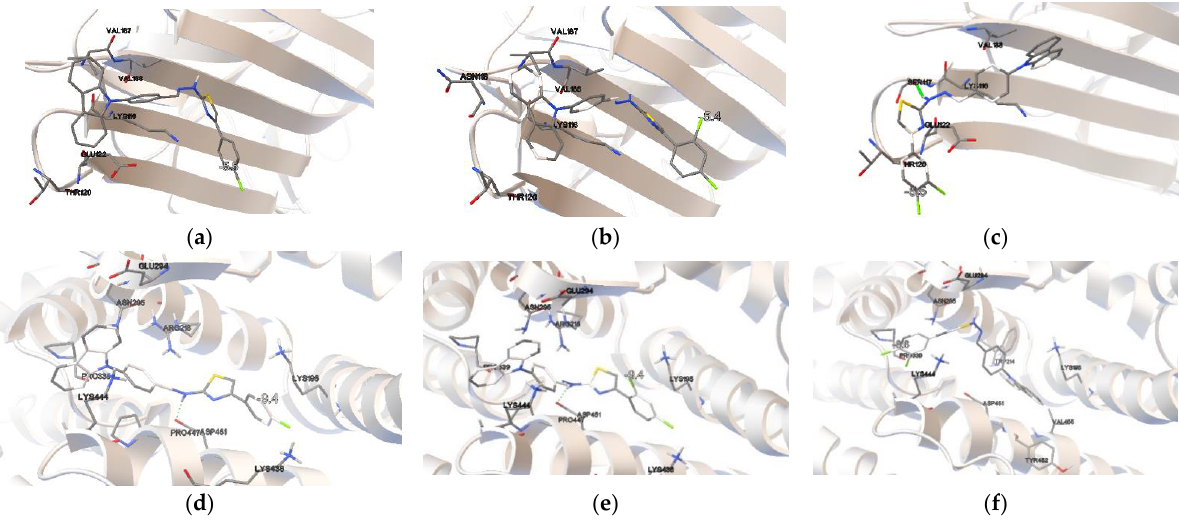
Figure 5. The results of Auto Dock simulations. ( a ) P1-ConA; ( b ) P2-ConA; ( c ) P3-ConA; ( d ) P1-HAS; ( e ) P2-HAS; ( f ) P3-HSA